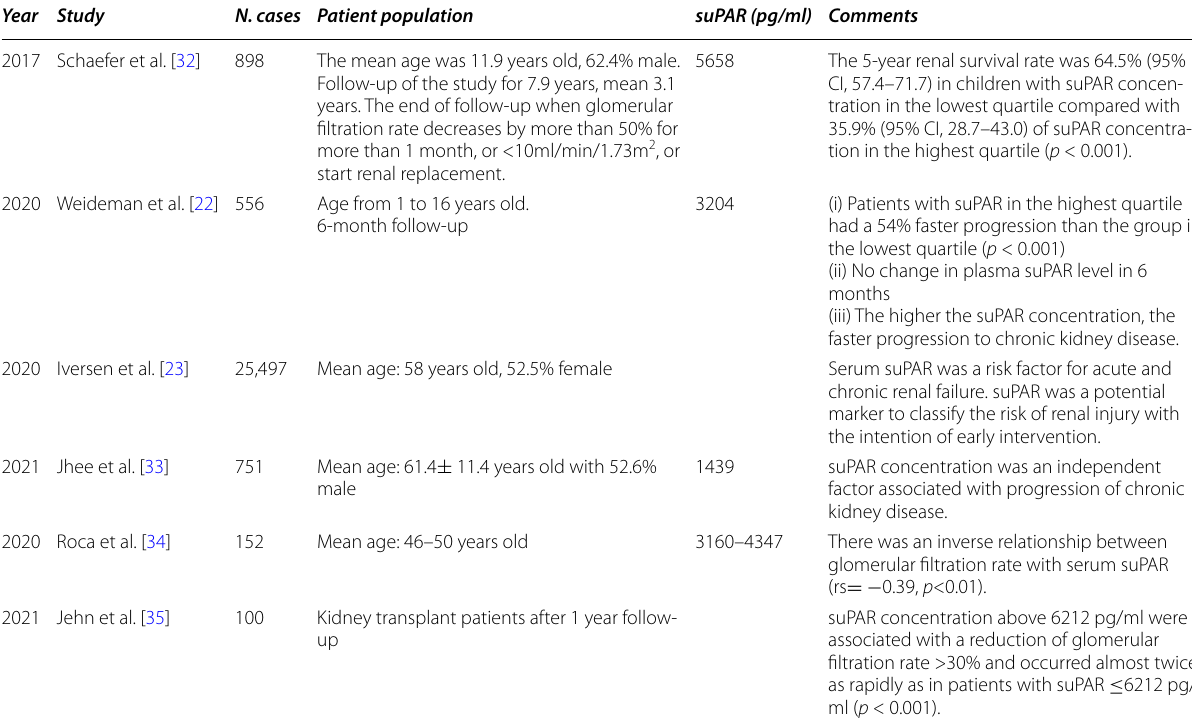
Table 4 Summary of studies on suPAR in relation to progression of renal failure Year Study N. cases Patient